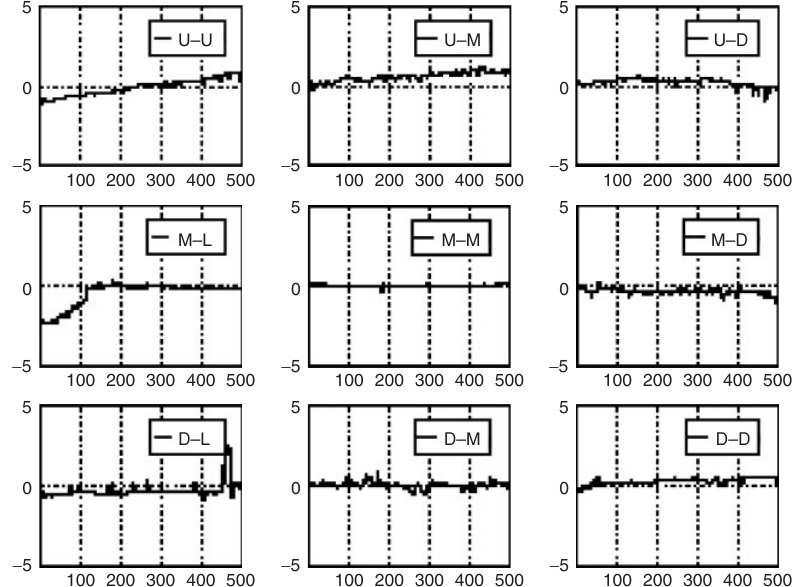
signals. The eye blink signal has less effect on the EOG signal that uses the middle-middle pair, but corrupts all the